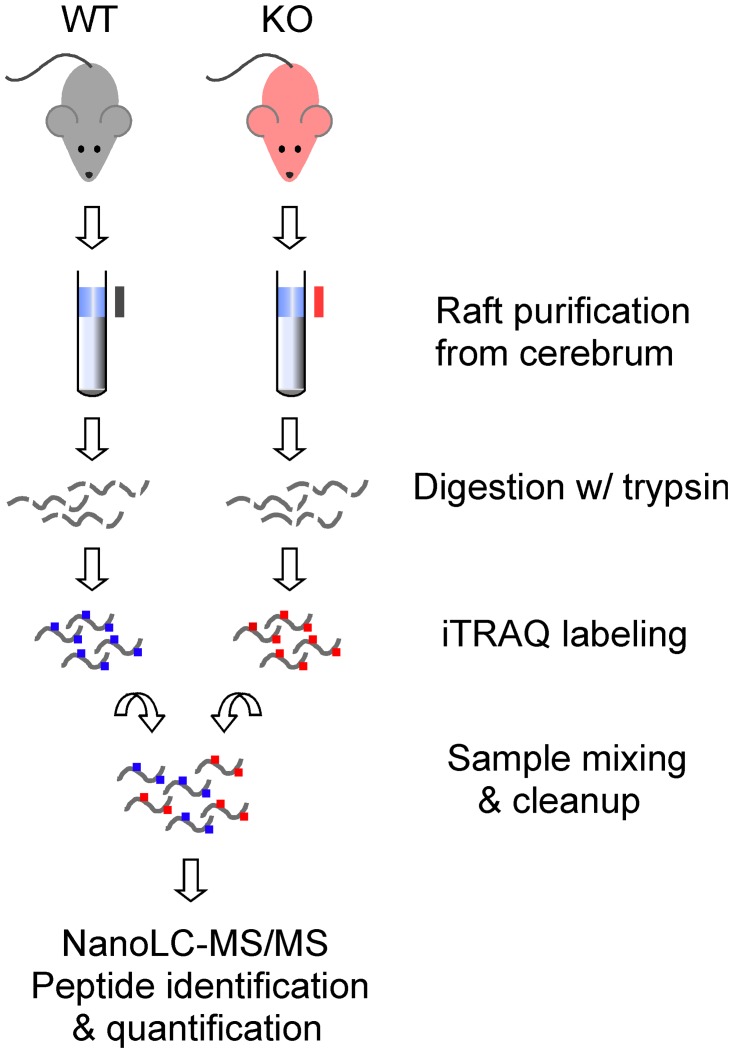
Workflow of iTRAQ proteomic strategy.Illustration of principal steps for qualitative and quantitative proteomic profiling of brain DRMs.